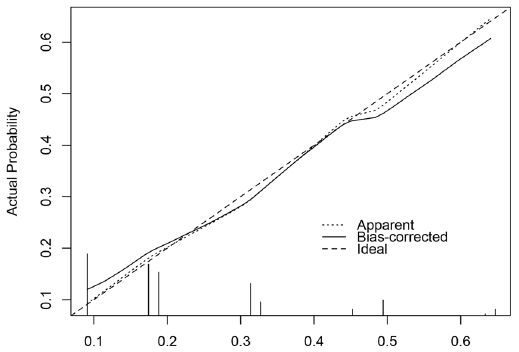
Figure 7. The calibration curve revealed adequate fit of the nomogram model in predicting the risk of